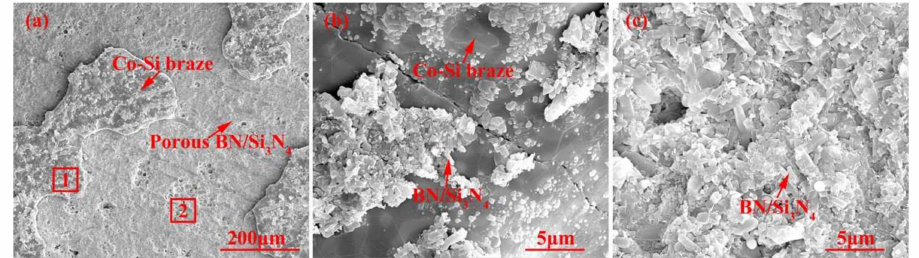
Figure 6. ( a ) Appearance characteristics of the reference welded joint fracture bonded at 1320 ◦ C for 10 min, ( b ) Area “1” of ( a ) magnified, and ( c ) Area “2” of ( a )